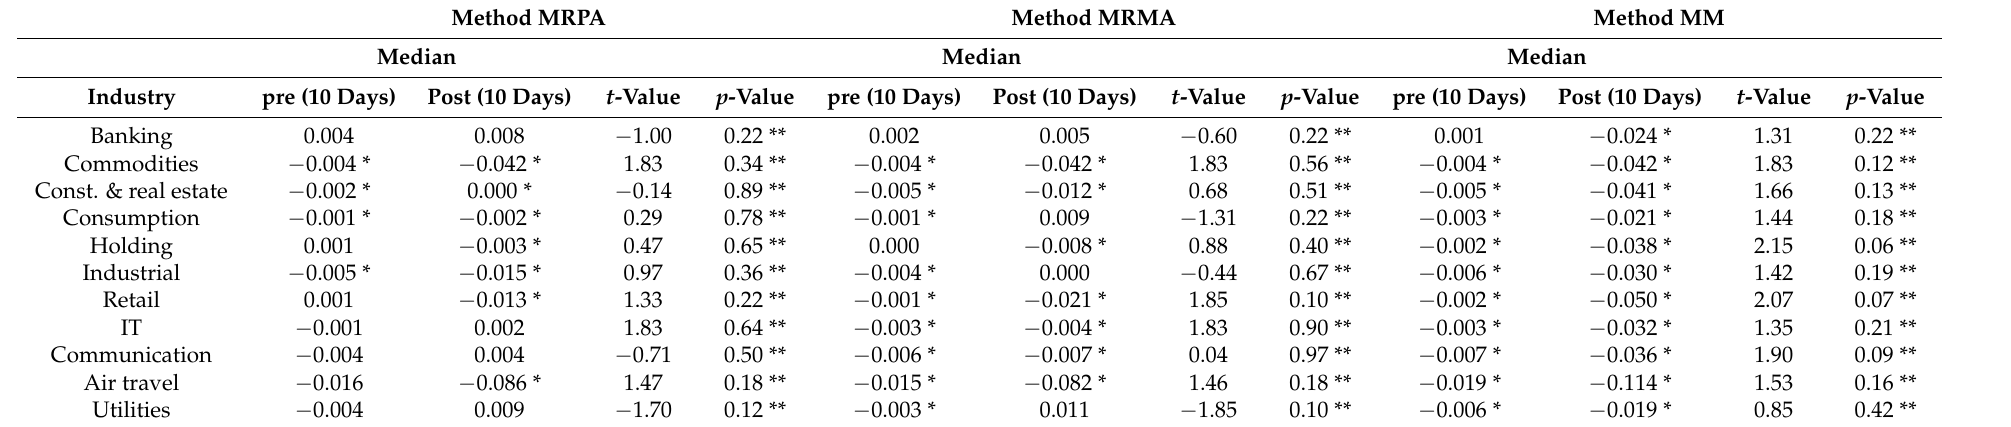
Table 8. Results from the t -test for the pre-event and post-event